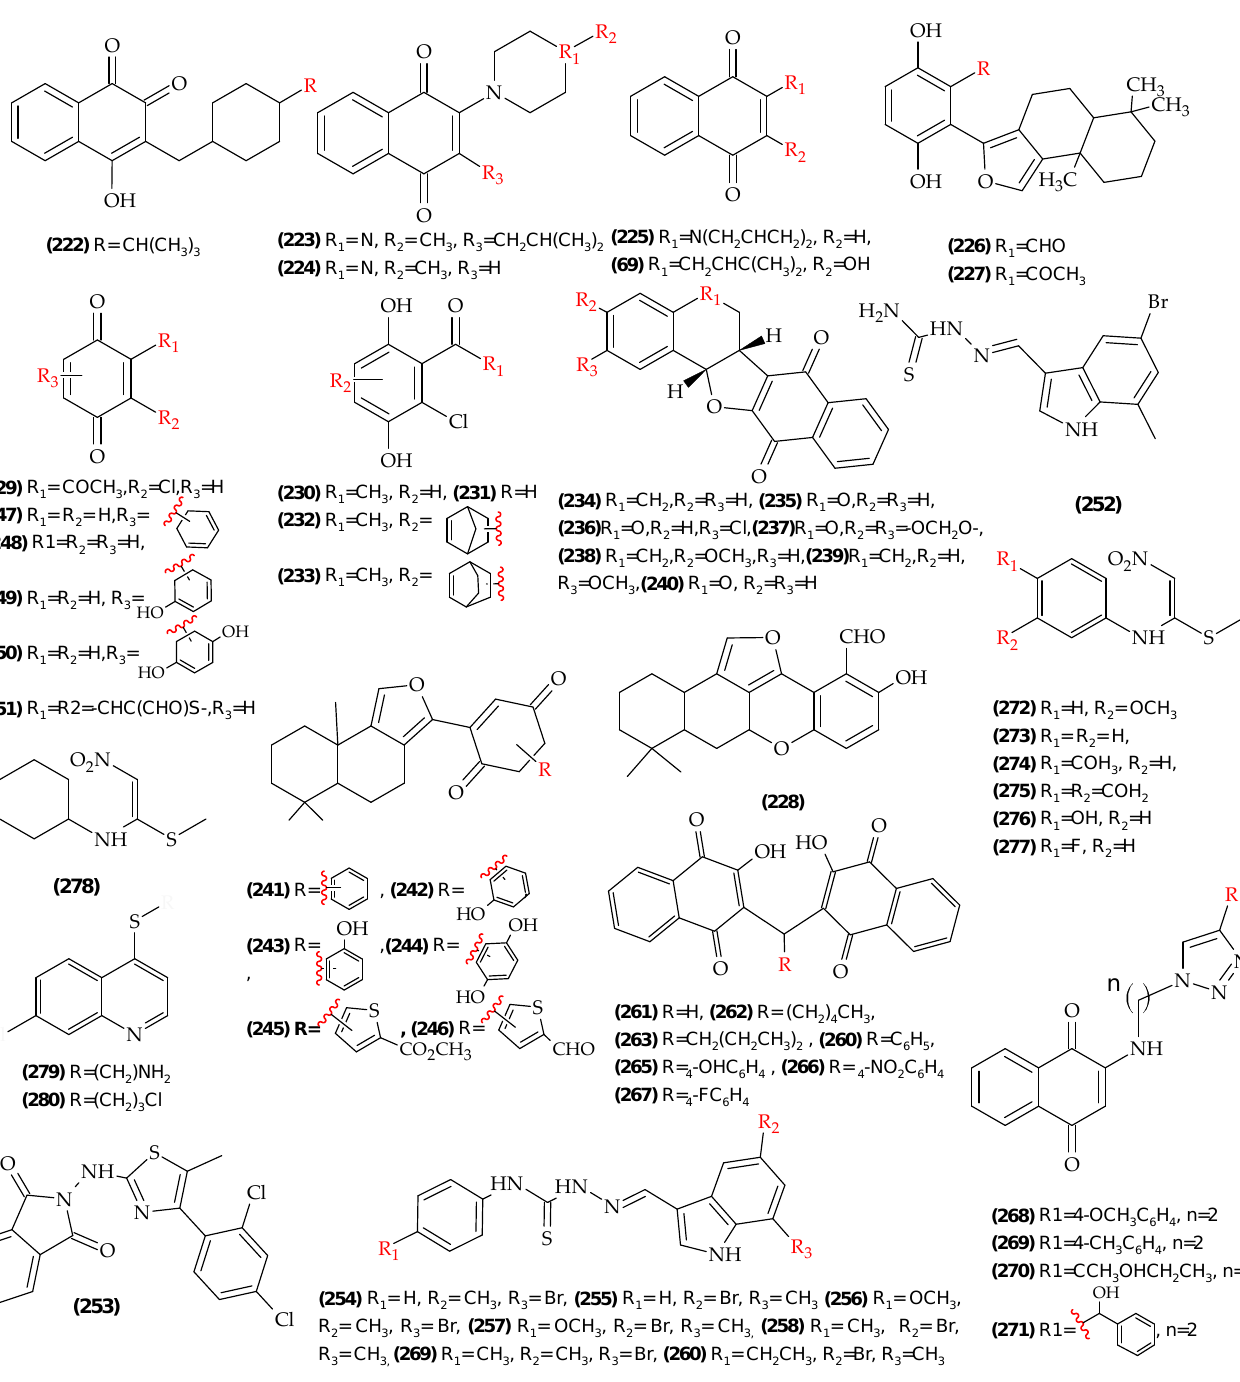
Figure A2. Molecules with reported biological activity used for the development of the anti-L. amazonensis QSAR model.